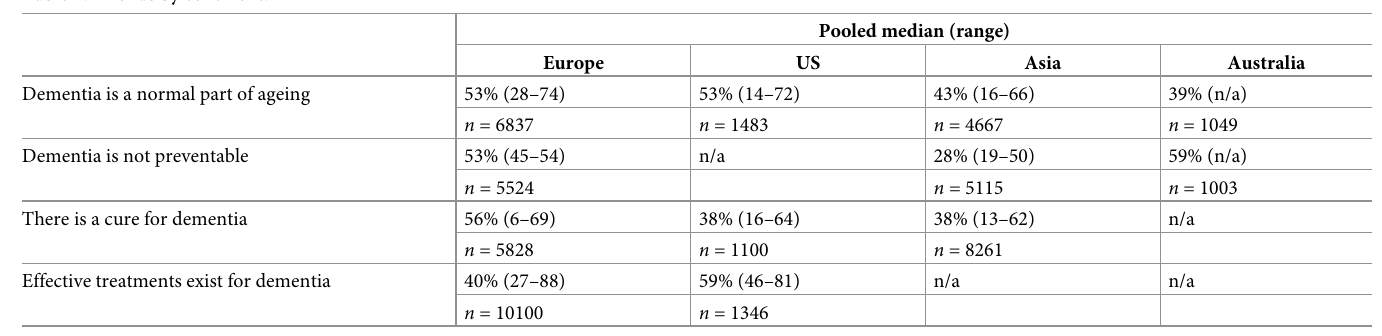
Table 2. Trends by